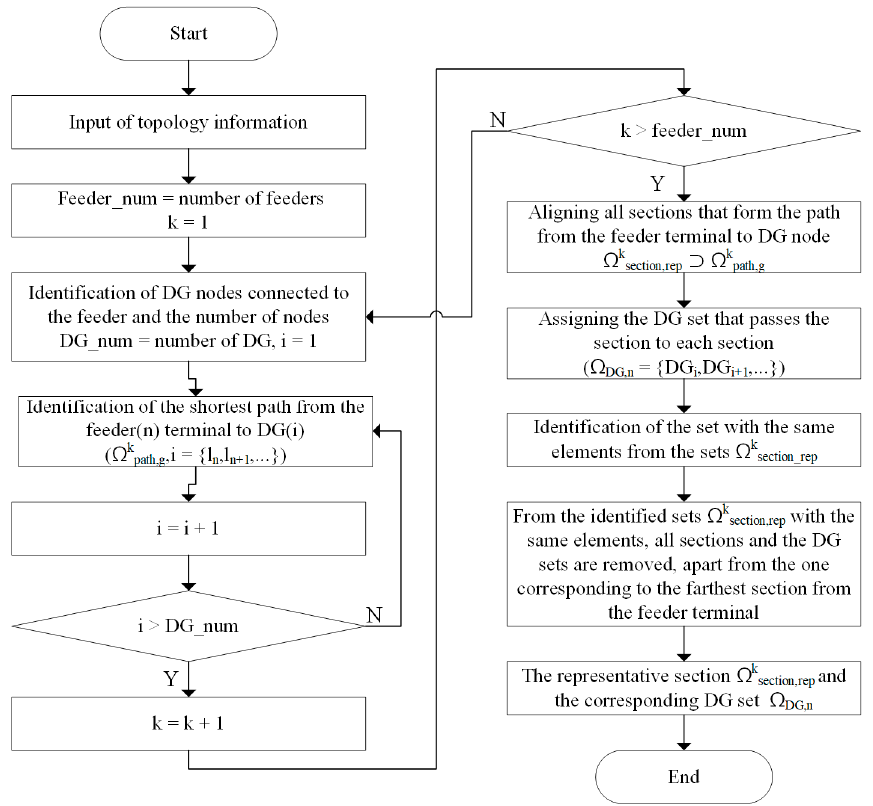
Figure 10. Flowchart for deriving a representative section.